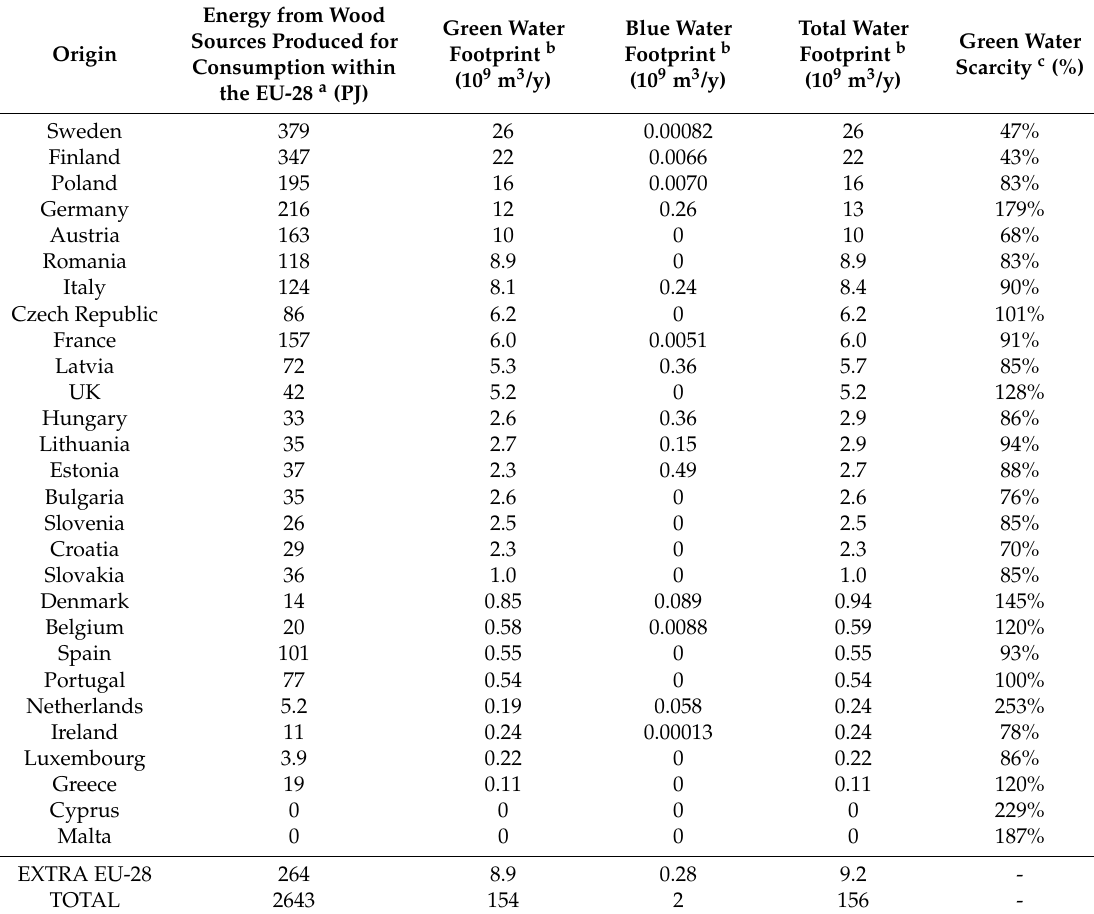
Table 2. The water footprint of wood for energy consumed in the EU in 2015 per country of origin. Member states are ordered top-down based on the largest total water